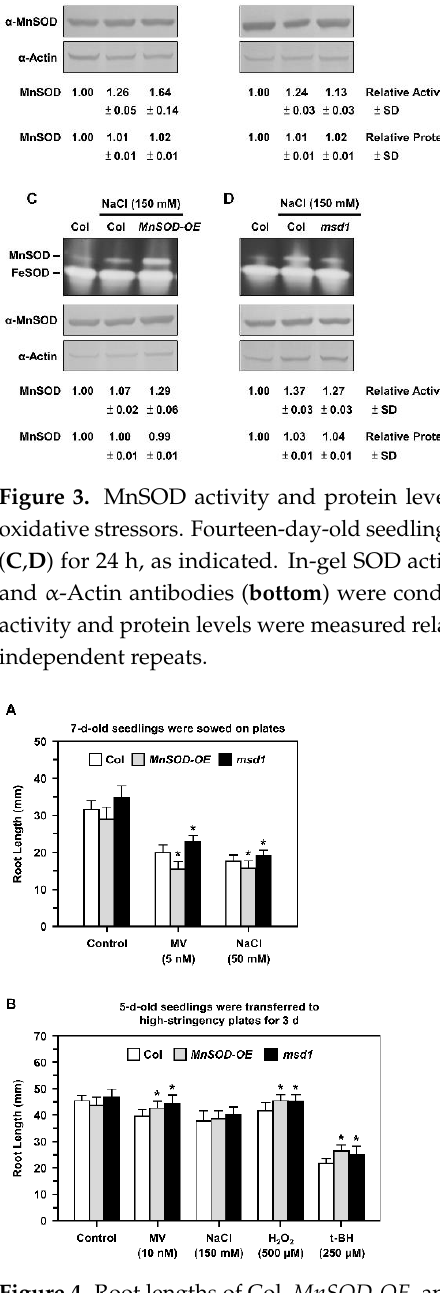
Figure 4. Root lengths of Col, MnSOD-OE , and msd1 seedlings during oxidative stress. ( A )